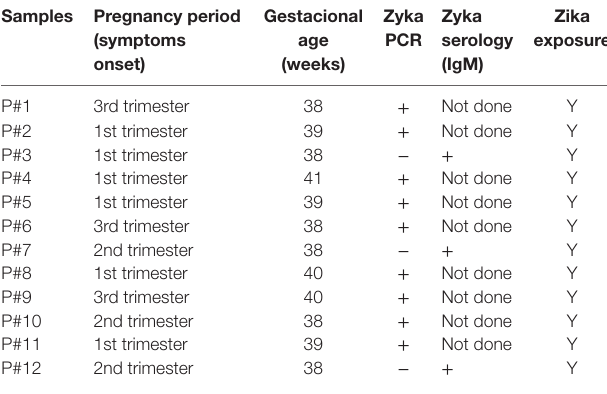
Table 2 | Clinical data of pregnant patients with Zika infection whose serum samples were included in the study.